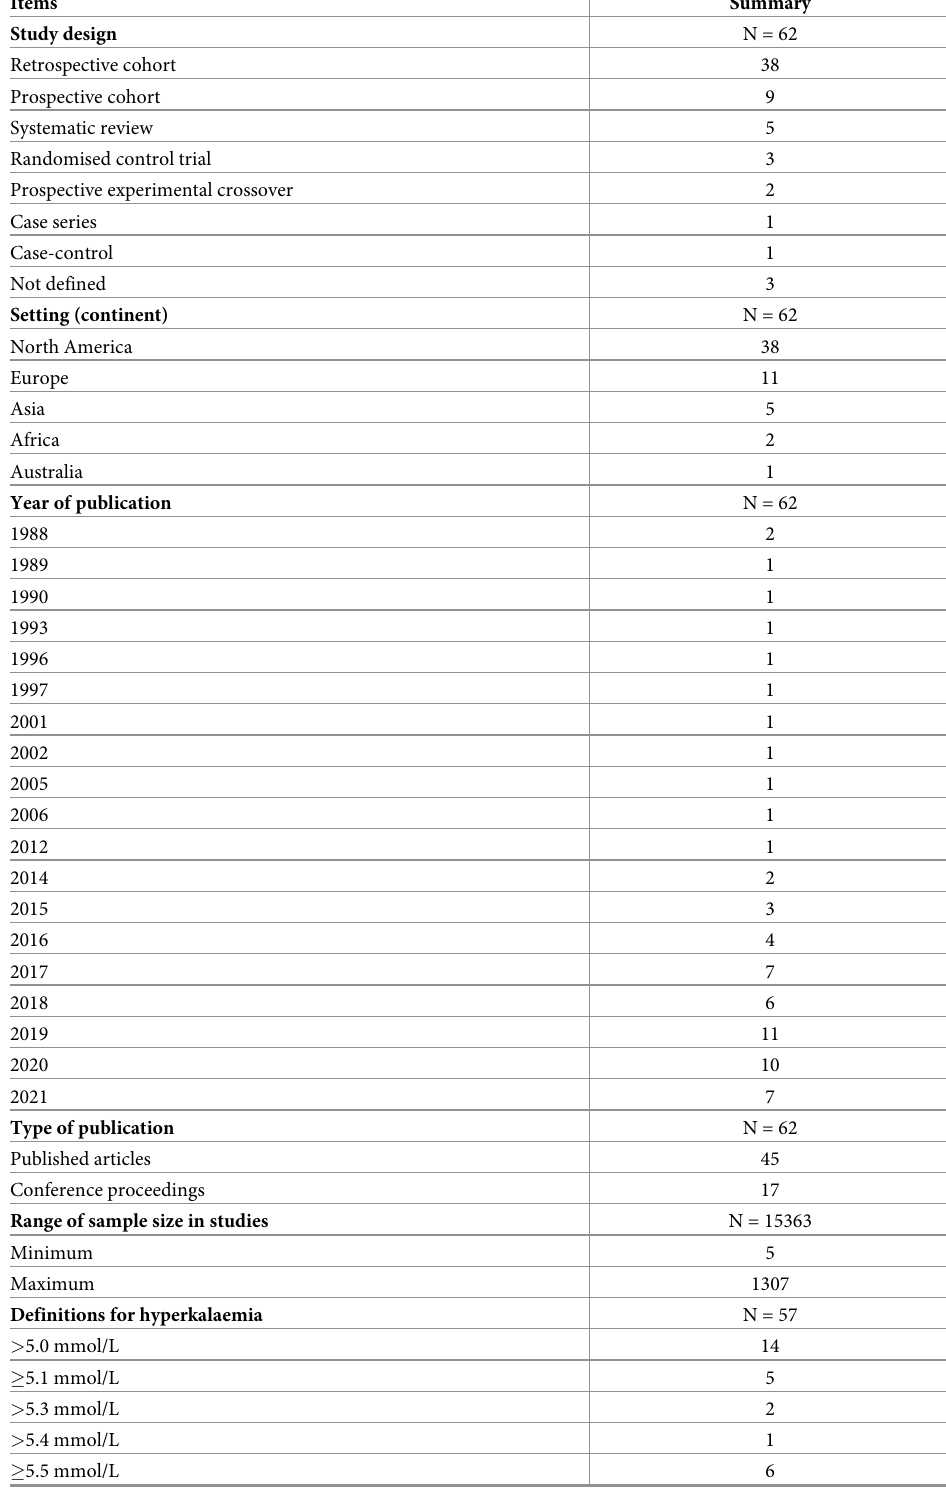
Table 1. Summary of characteristics of included